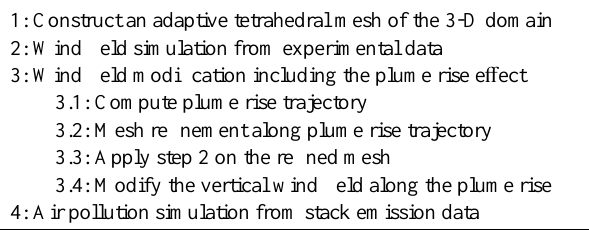
Algorithm 1 Wind and air pollution modeling